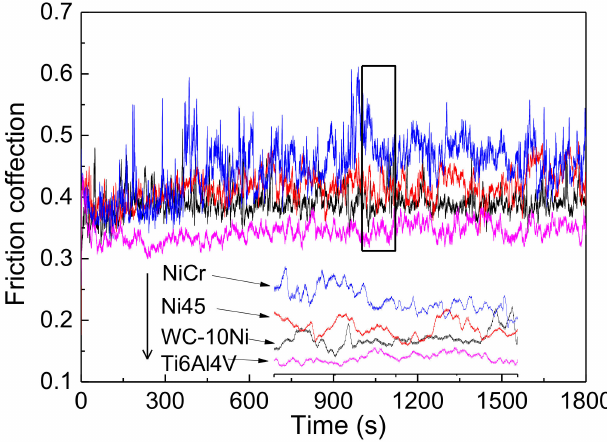
Figure 7. Friction coefficient of Ti6Al4V alloy and coatings.